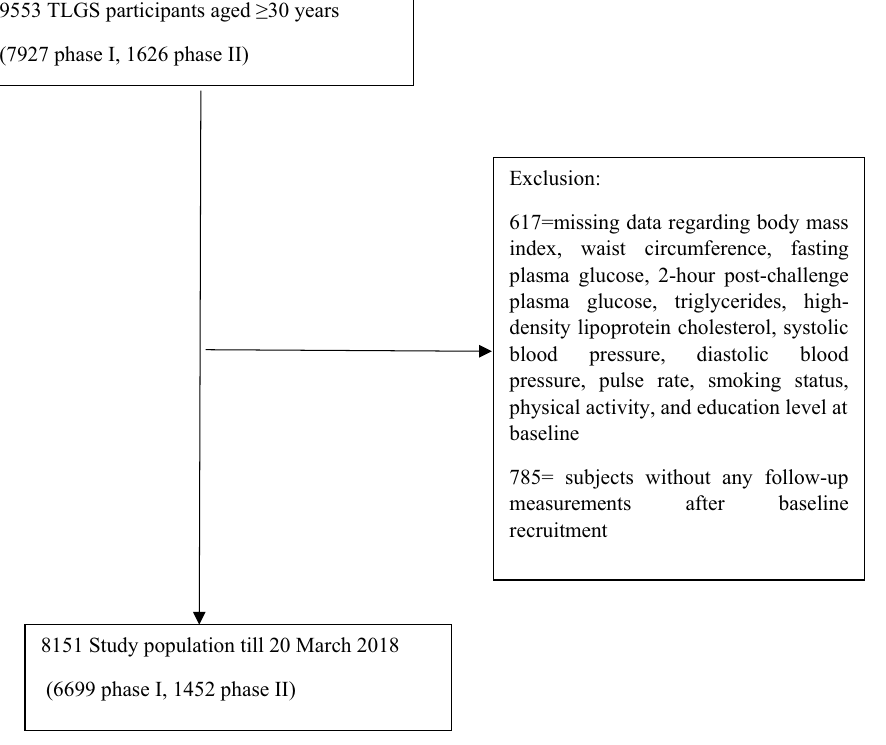
Figure 1. Study flowchart: TLGS: Tehran Lipid and Glucose